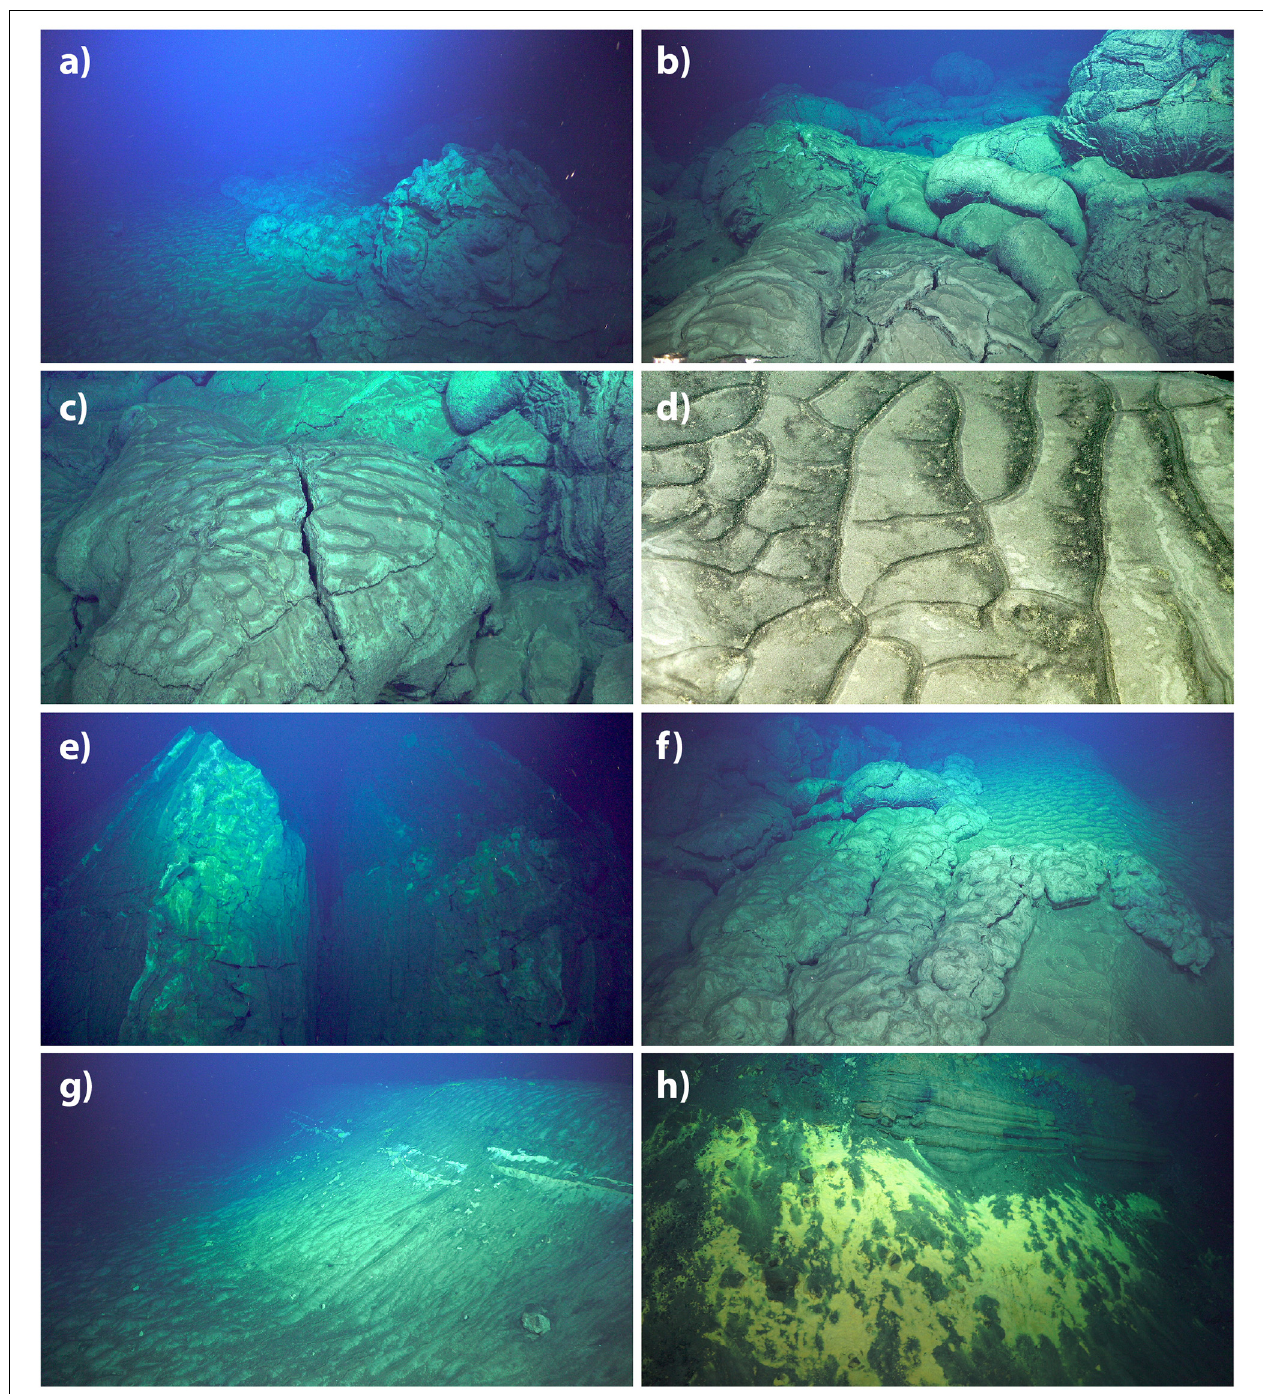
FIGURE 13 | Images of eruption site #4 from ROV SuBastian dive S88. Numbers in parentheses are time of photo in GMT and horizontal scale. See Figure 12d for photo locations. (a) Margin of 2012–2016 pillow lavas at right (21:32:51, 8 m). (b) Closer view of 2012–2016 pillow lavas (21:11:48, 3 m). (c) Lava lobe with rippled volcaniclastic-rich sediment on surface (21:05:22, 2 m). (d) Close up of rippled volcaniclastic-rich sediment (21:47:26, 0.5 m). (e) Uplifted lava at tumulus structure (23:18:54, 8 m). (f) 2012–2016 pillow lava (left) lapped up on south edge of uplifted sediment dome at right (23:50:51, 3 m). (g) Broad swale (left) and edge of extension crack (right) in southern part of uplifted sediment dome (00:32:58, 10 m). (h) Yellow microbial mat growing on edge of extensional crack with stratigraphy in central part of uplifted sediment dome (00:35:18, 5 m).